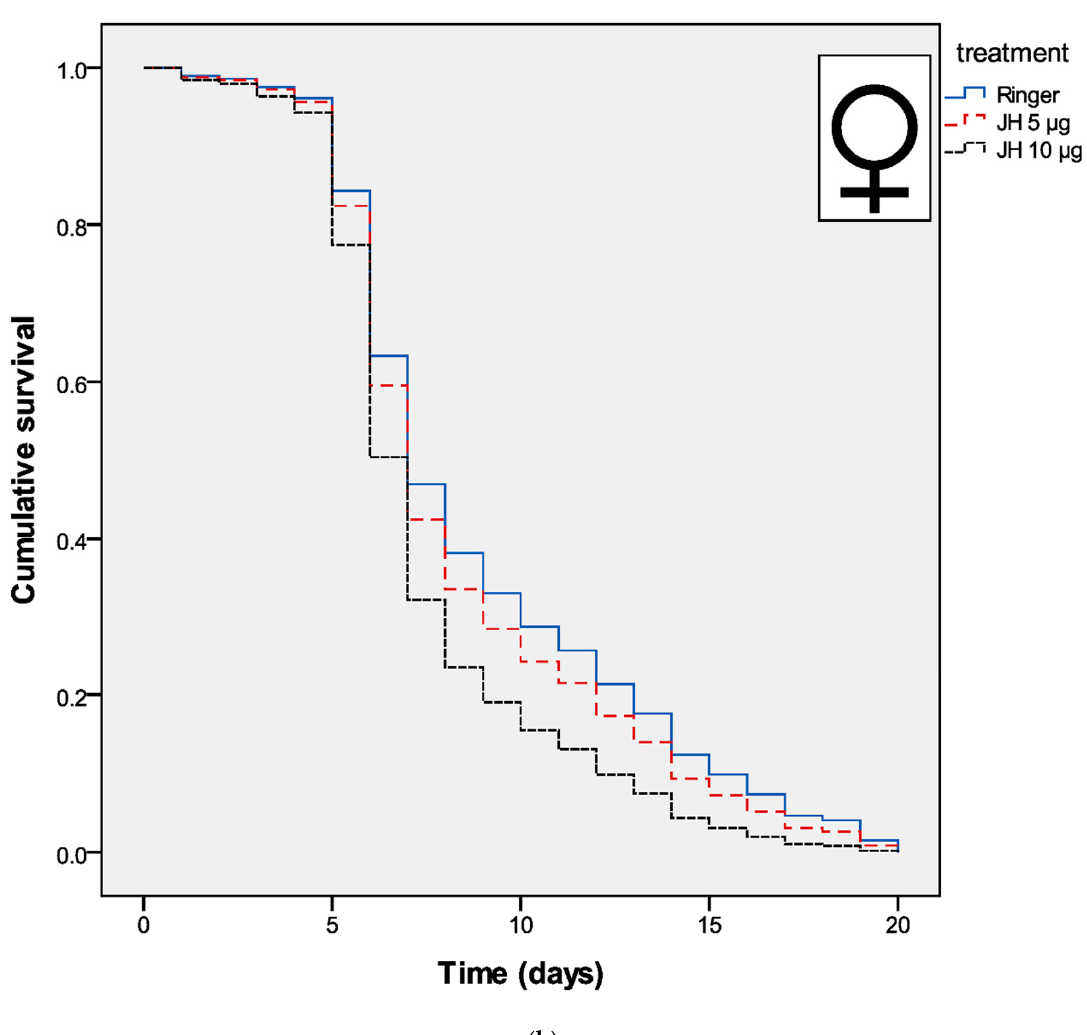
Figure 1. Cumulative survival of ( a ) male and ( b ) female beetles after topical application with the entomopathogenic fungi M. robertsii . Curves represent the survival functions calculated by the Cox regression survival analysis.